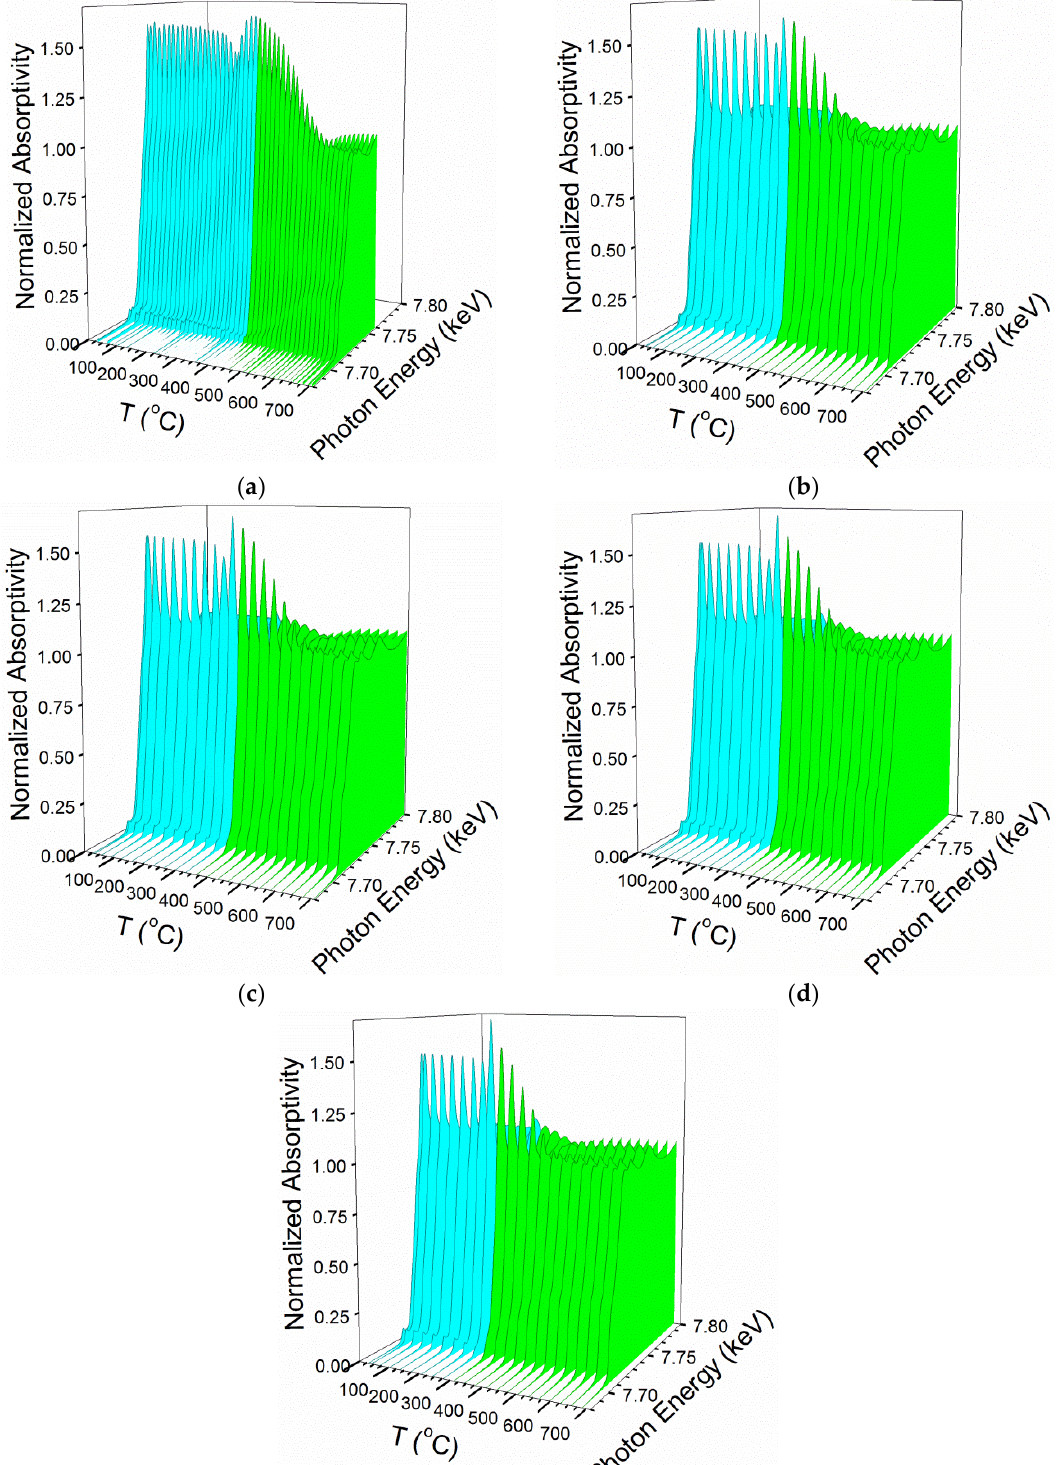
Figure 4. H 2 -TPR-XANES spectra at the Co K-edge of ( a ) 25%Co/Al 2 O 3 , ( b ) 25%M (M = 5%Ni-95%Co)/Al 2 O 3 , ( c ) 25%M (M = 10%Ni-90%Co)/Al 2 O 3 , ( d ) 25%M (M = 25%Ni-75%Co)/Al 2 O 3 , and ( e ) 25%M (M = 50%Ni-50%Co)/Al 2 O 3 .